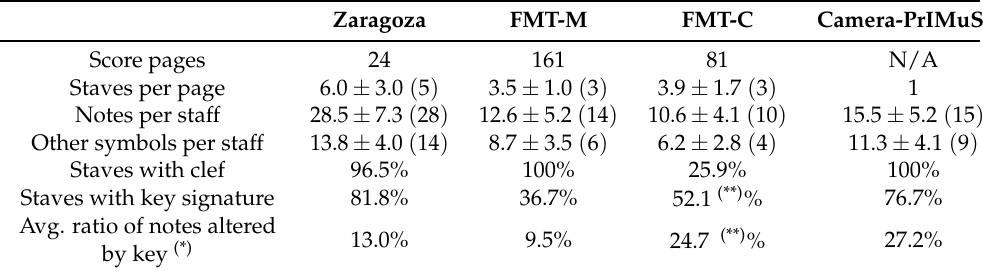
Table 2. Some statistics about the semantic contents of datasets. Numbers in the form a ± s ( m ) express average, standard deviation, and mode, respectively. (**) These figures include staves with absent keys, for which the keys of the first staves in the same pieces are assumed.